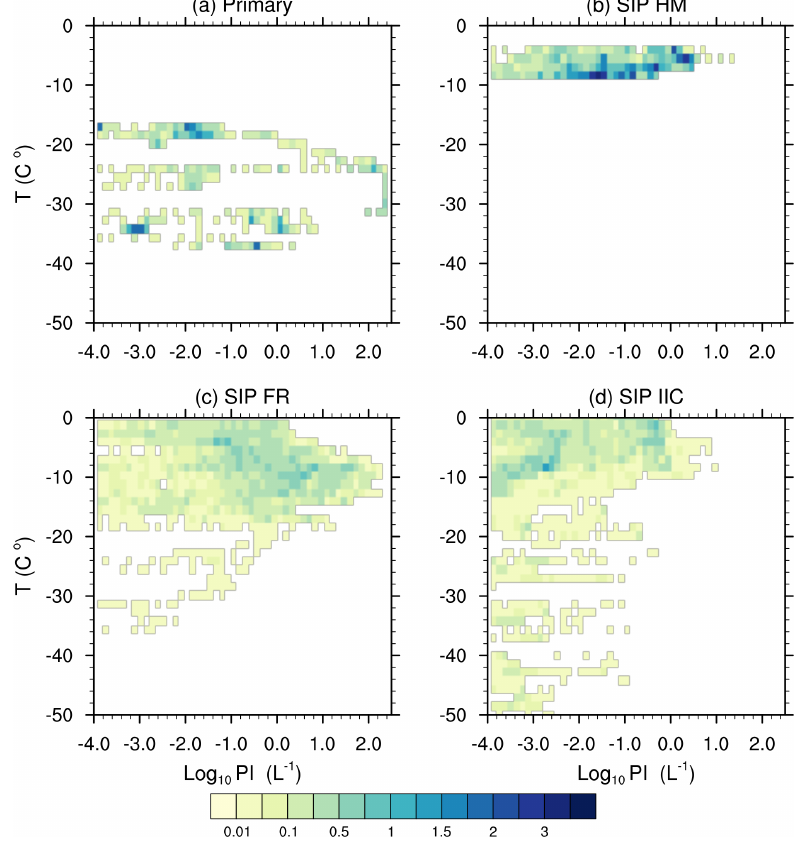
Figure 12. Bivariate joint probability density function of ice production defined in terms of temperature and ice production, (a) primary ice production; (b) ice production from riming splintering; (c) ice production from rain fragmentation; (d) ice production from ice–ice collision. The ice production (PI, with unit of #L − 1 ) is calculated as ice production rate (L − 1 s − 1 ) multiplied by model time step (20min), shown in Log 10